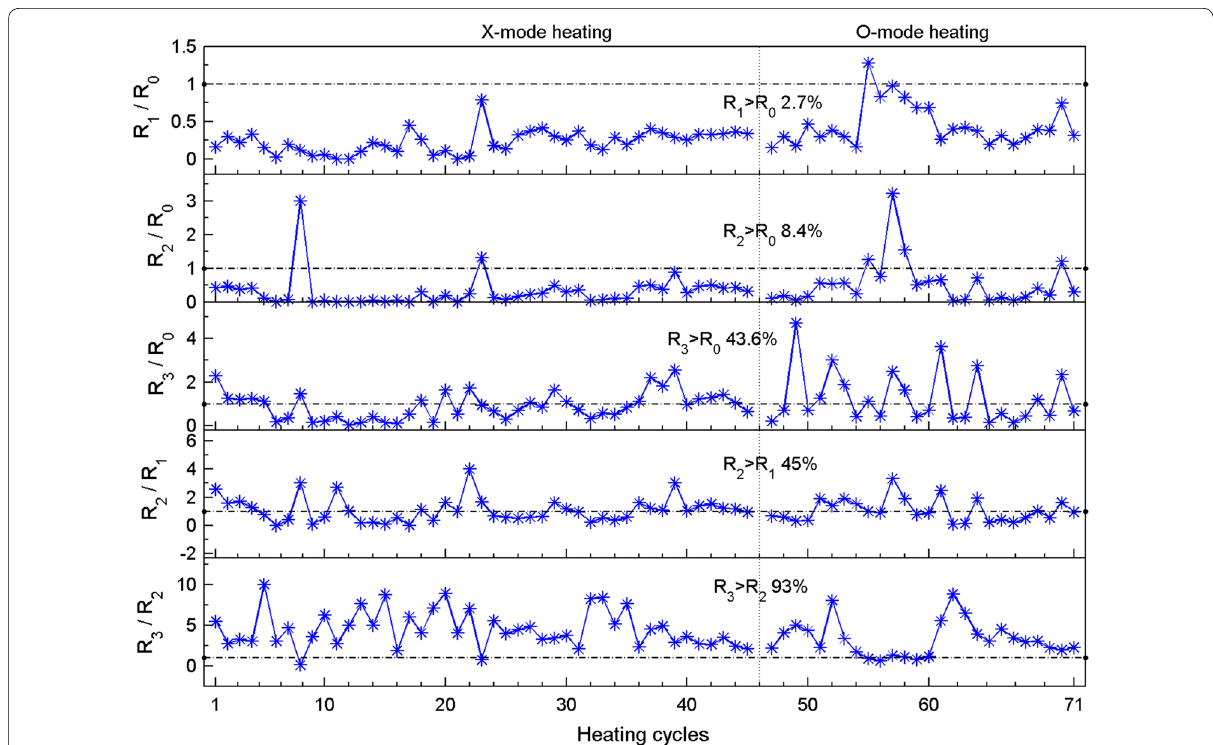
Fig. 5 As for Fig. 3 but for case 3a. In this case, the HF transmitter was operated with one frequency 5.423